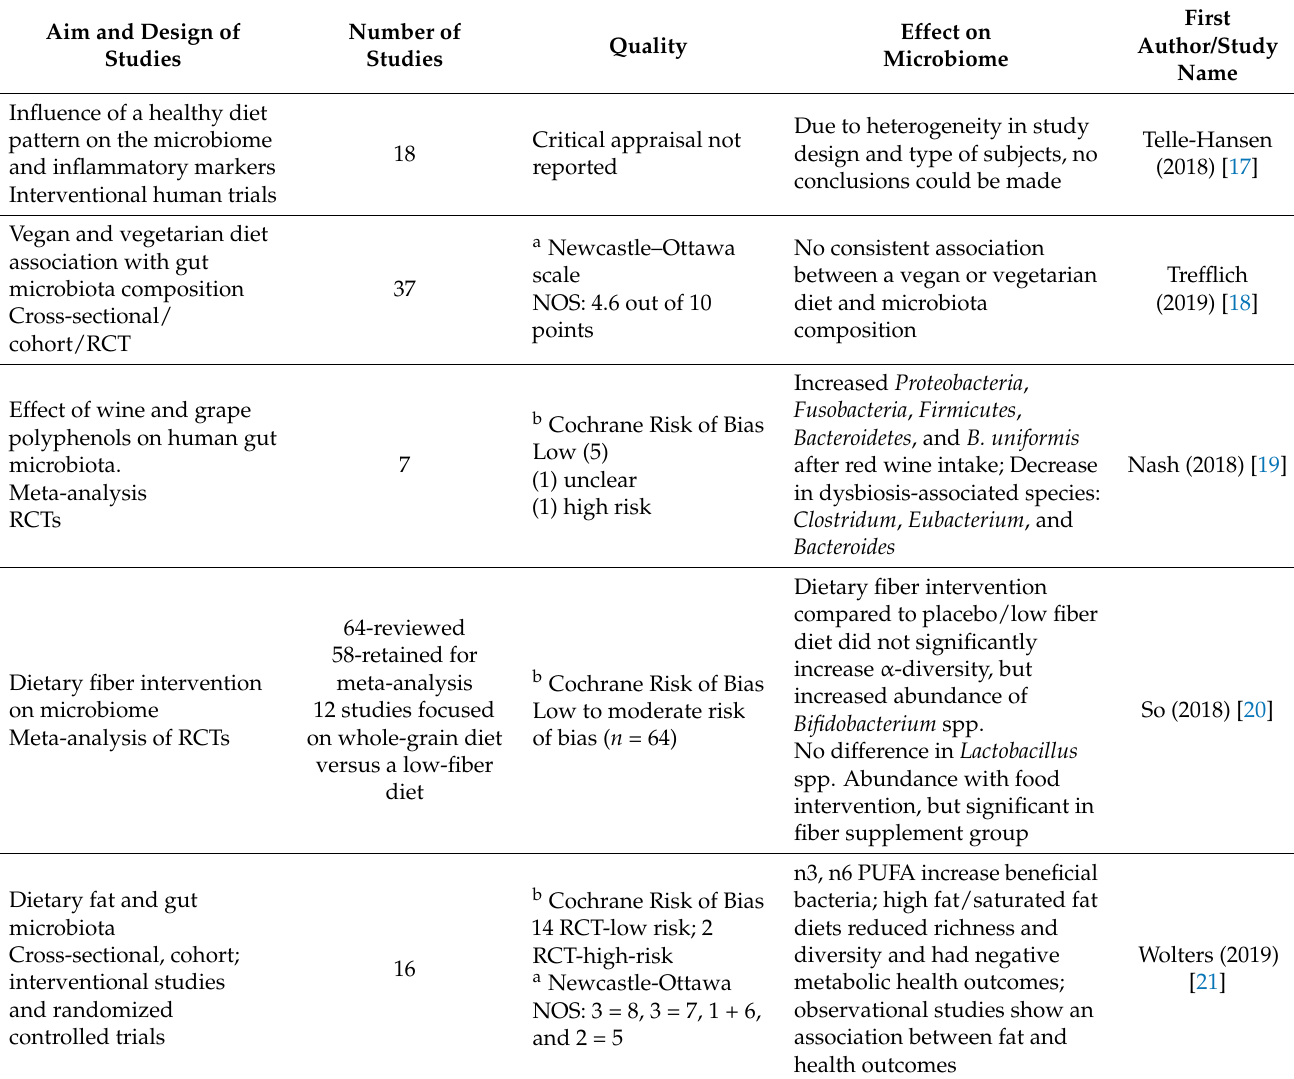
Table 2. Summary of systematic reviews and metanalyses on the effect of diet or exercise on the